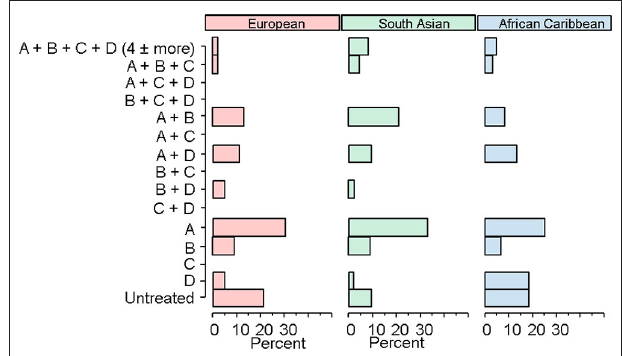
FIGURE 2 | Ethnic patterns of antihypertensive medication.